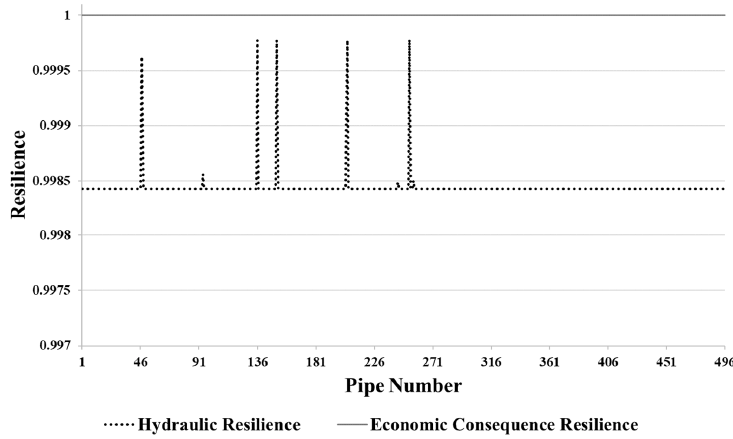
Figure 4. R Hyd and R ECLIPS values for all iterations of the pipe replacement Figure 4. 𝑅 (cid:3009)(cid:3052)(cid:3031) and 𝑅 (cid:3006)(cid:3004)(cid:3013)(cid:3010)(cid:3017)(cid:3020) values for all iterations of the pipe replacement analysis.